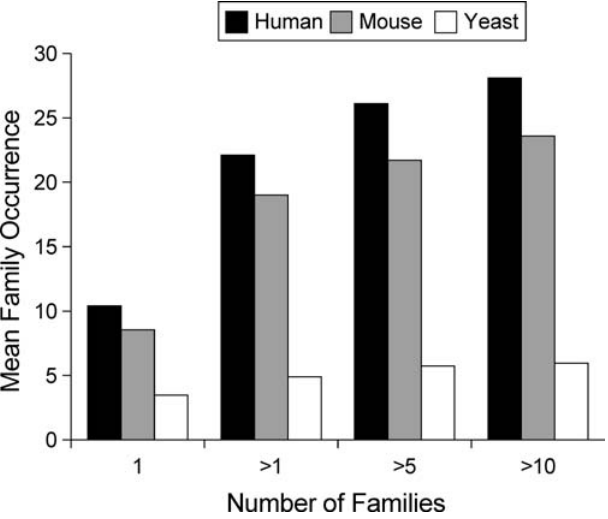
Figure 3. Family Occurrence and Family Counts of Ancient Folds Ancient SCOP folds were divided into a number of bins according to the number of families that they contain ( x -axis). For each bin, the mean family occurrence (the mean number of proteins in which the SCOP families in these folds appear) for human, mouse, and yeast proteins is shown. As the number of families in a SCOP fold increases, the occurrence of families belonging to these folds in the proteome tends to increase. Significant (MW-test, KS-test: p , 0.05) occurrence differences were found between folds of one and more than ten families in human and mouse. No significant differences were detected in yeast. The differences in mean family occurrence between mammals and yeast tend to be larger for folds with larger numbers of families. These interspecies differences between folds of one family and those of more than one family are significant (MW-test: p , 0.1; KS-test: p , 0.001). DOI: 10.1371/journal.pcbi.0020040.g003